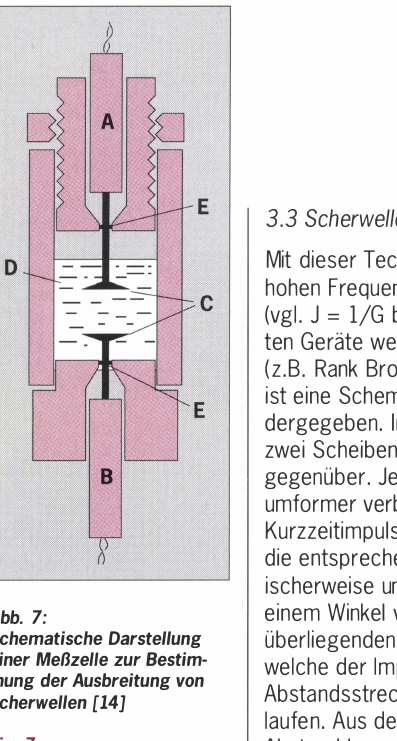
Fig. 7: Schematic illustration of the shear-wave propagation cell: A and B represent the receiving and driving crystal transducer assemblies, C the Perspex discs, D the dispersion and E the silicone rubber seals